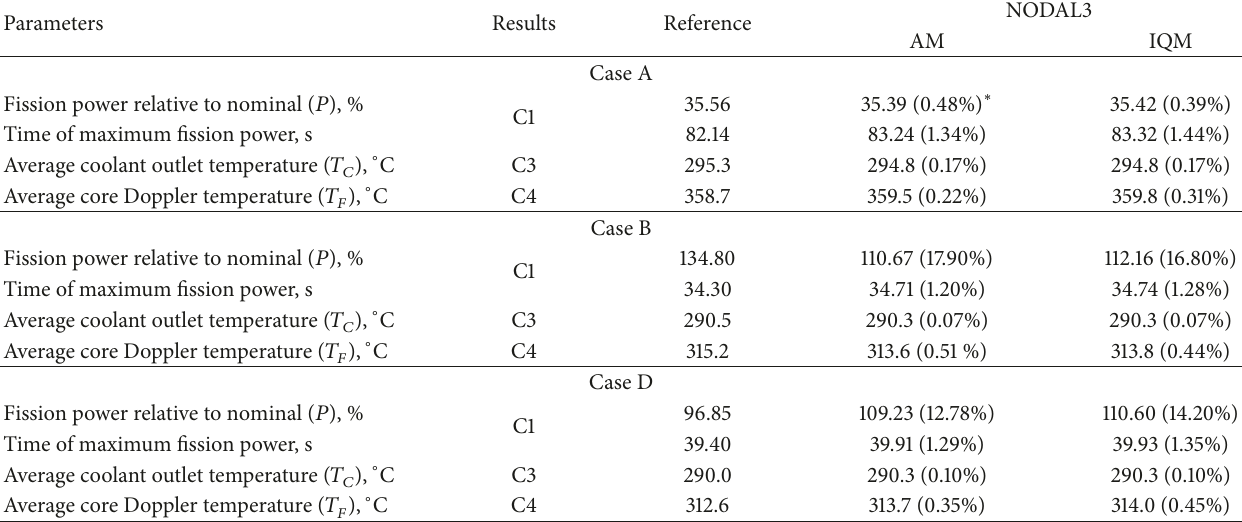
Table 4: Transient core averaged results for Cases A, B, and D.